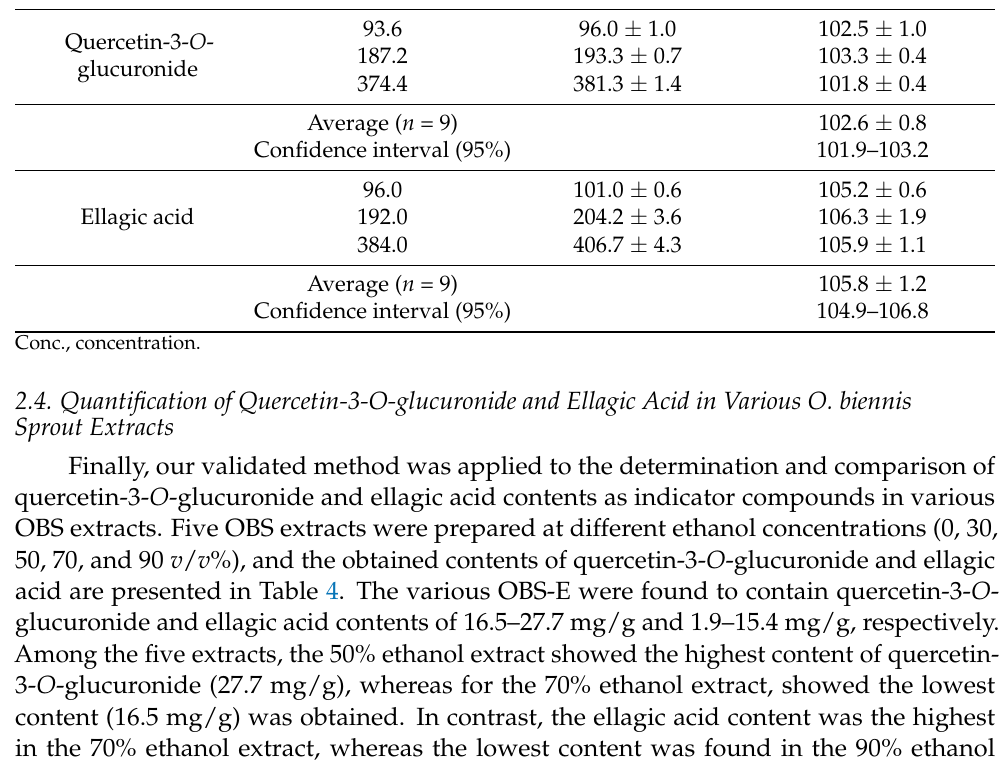
Table 3. Results of accuracy validation for quercetin-3- O -glucuronide and ellagic acid. Standard